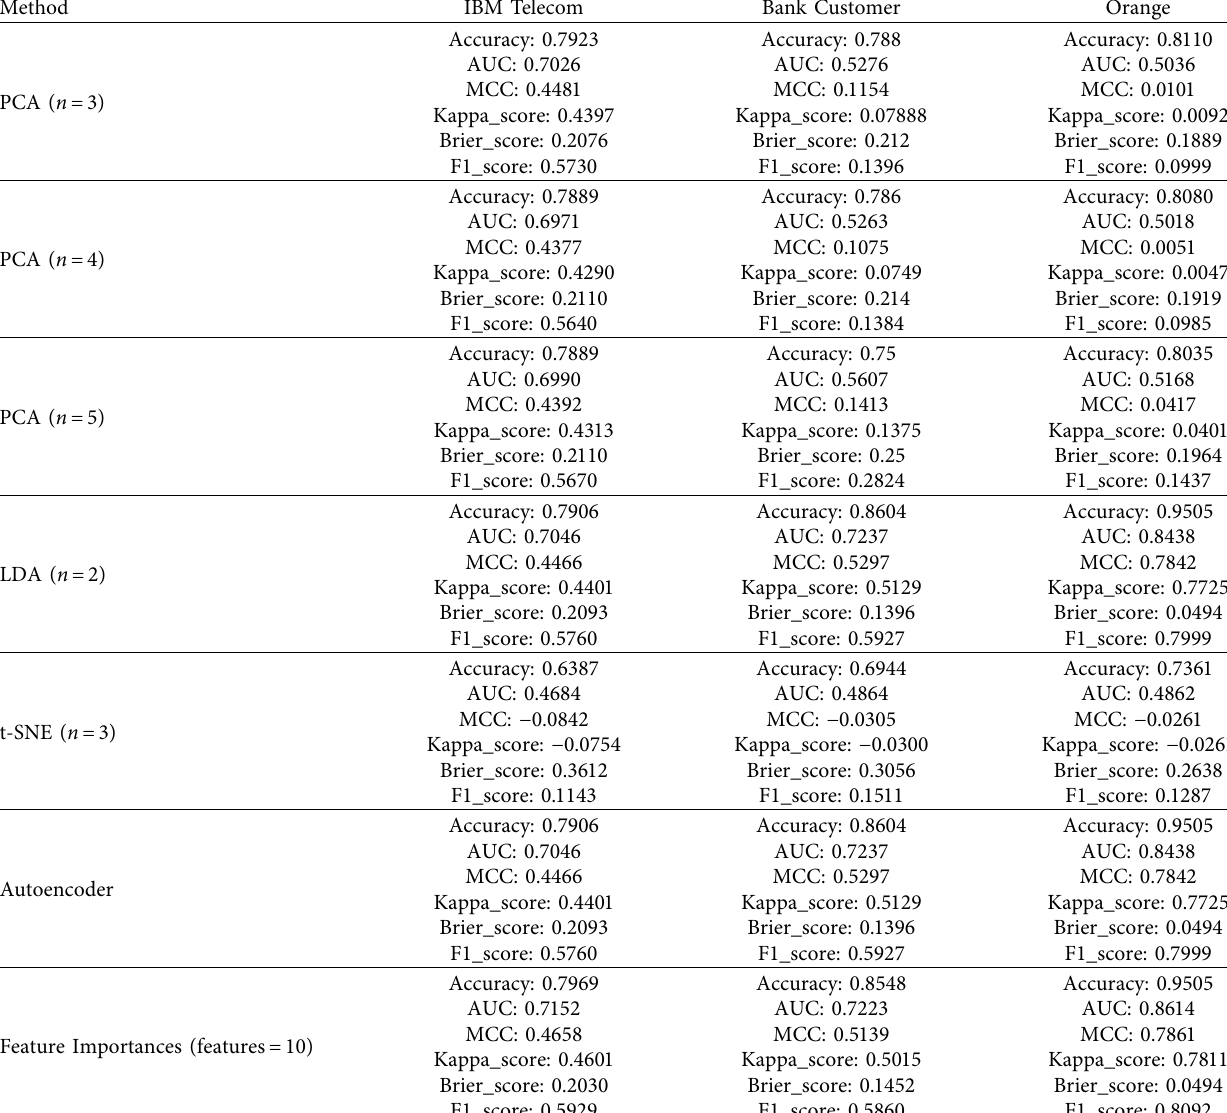
Table 7: Evaluation results of feature reduction methods.